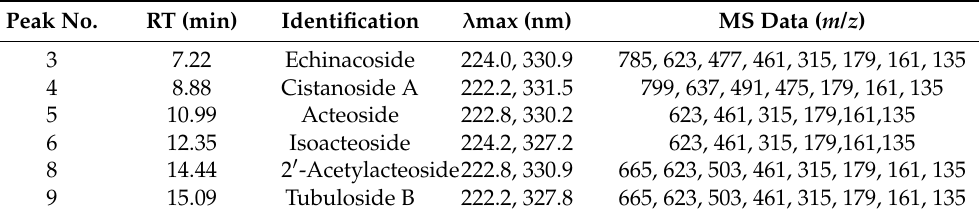
Table 6. Identification of six PhGs by UPLC-ESI-Q/TOF-MS. Peak